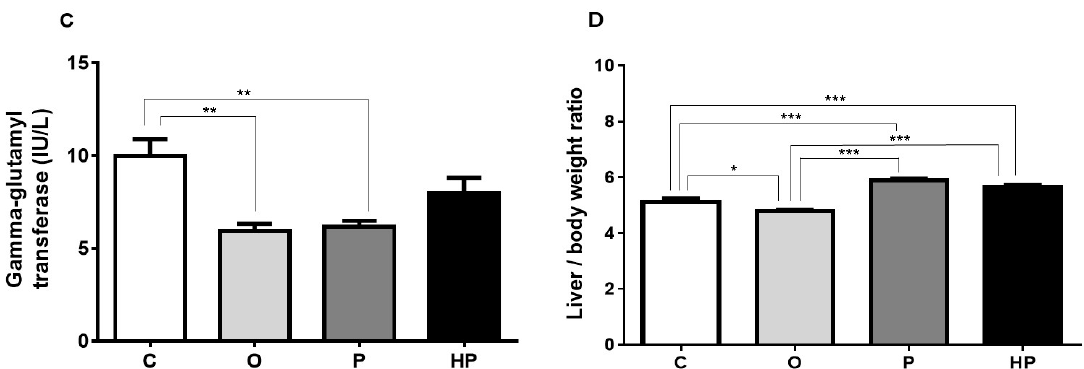
Figure 4. Effects of each diet on liver dynamics. ( A ), AST/ALT ratio; ( B ), alkaline phosphatase; ( C ), gamma-glutamyl transferase; ( D ), Liver weight/body weight ratio. Data presented as mean ± standard error of the mean ( n = 6). * p ≤ 0.05; ** p ≤ 0.01; *** p ≤ 0.001. AST = aspartate aminotransferase; ALT = alanine aminotransferase; C = control group; O = olive oil group; P = palm oil group; HP = hybrid palm oil group.